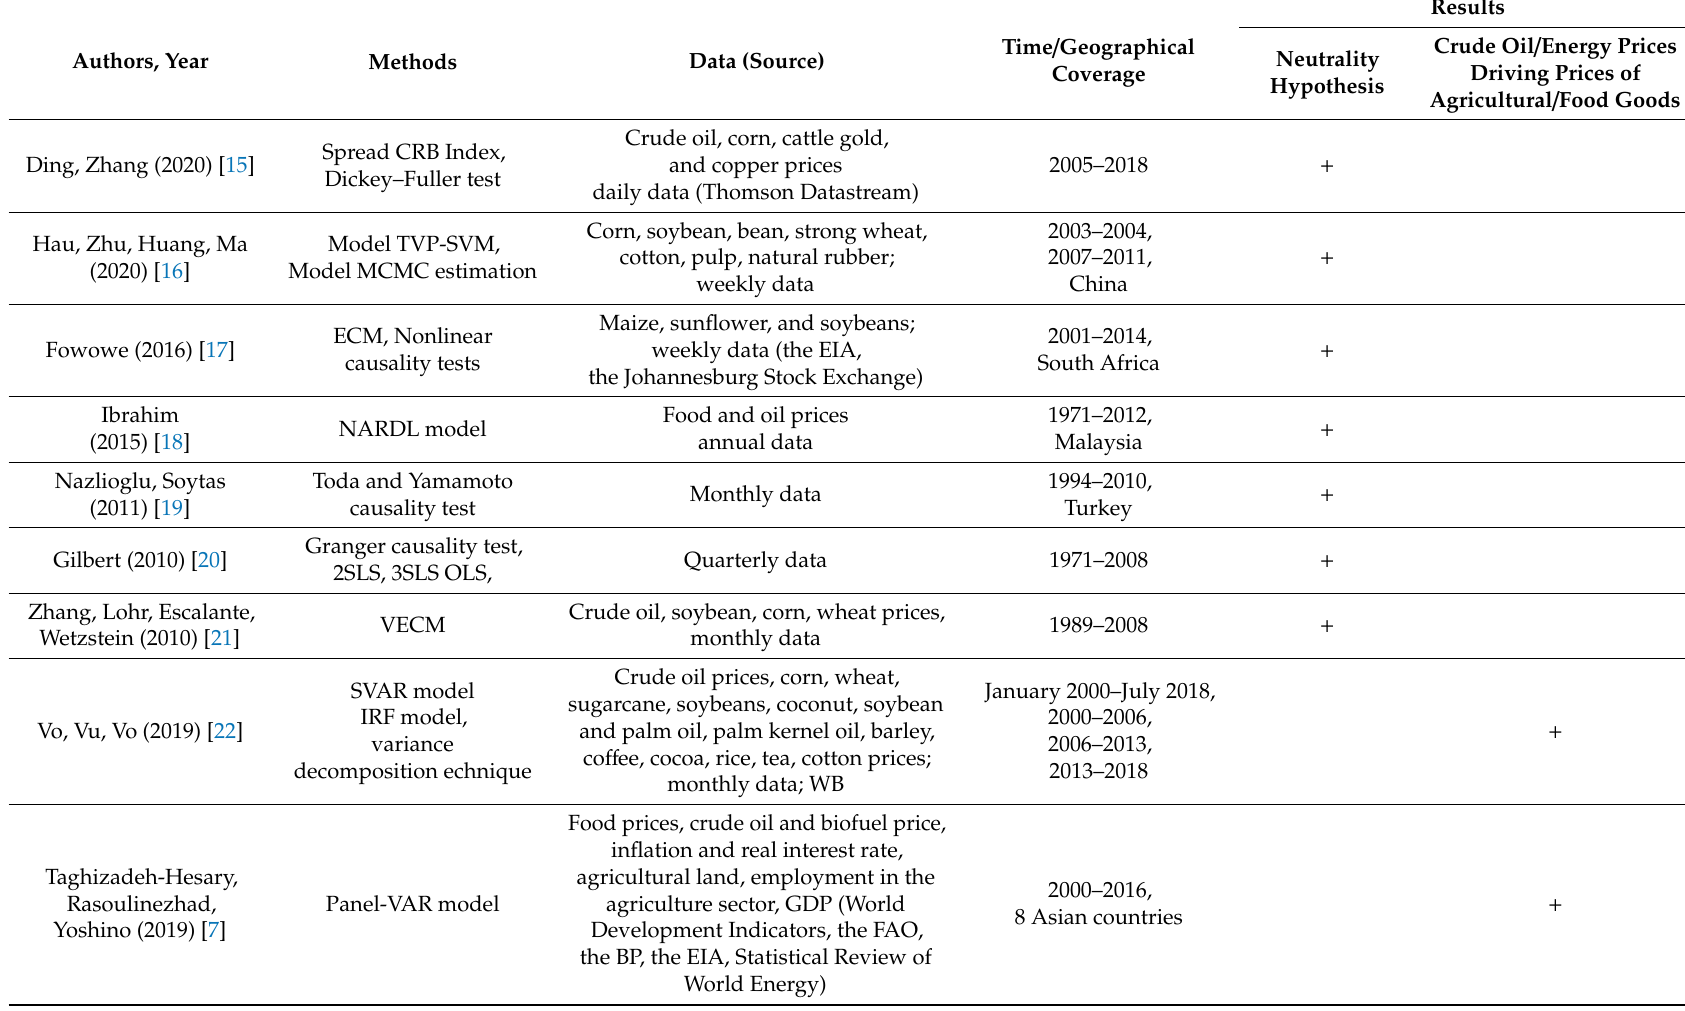
Table 1. Overview of previous studies and